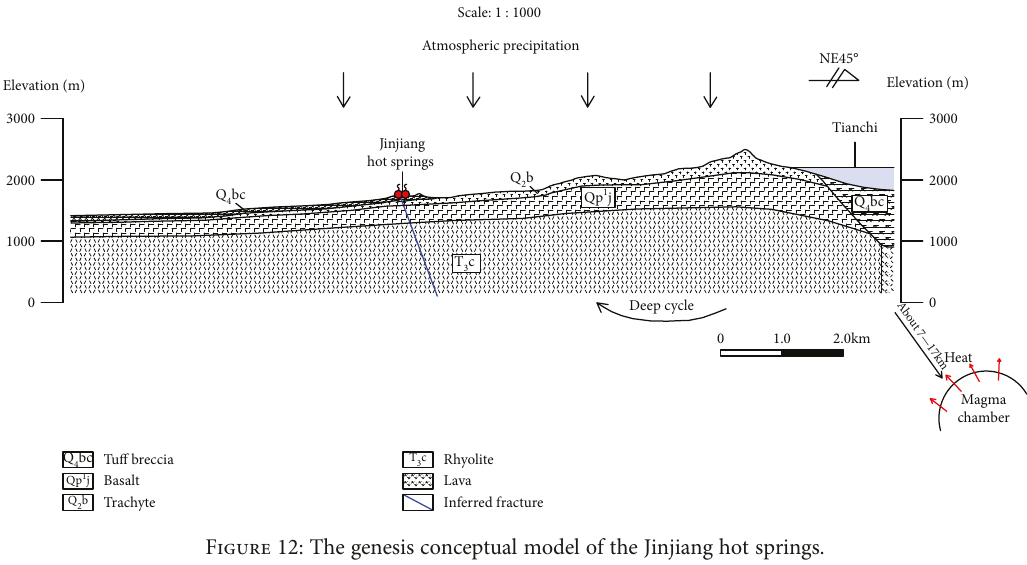
Figure 12: The genesis conceptual model of the Jinjiang hot springs.